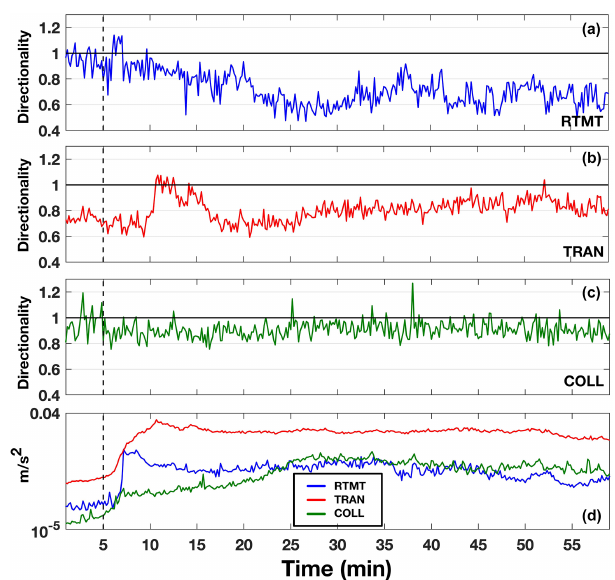
Figure 6. Directionality ratio plots over time for RTMT (a) , TRAN (b) , and COLL (c) . Vertical rms seismic signals for the three stations are plotted in panel (d) , where blue is RTMT, red is TRAN, and green represents COLL. The dashed vertical lines mark the tim- ing of the lahar front passing the monitoring station. All DRs and rms amplitudes were calculated using 10s time